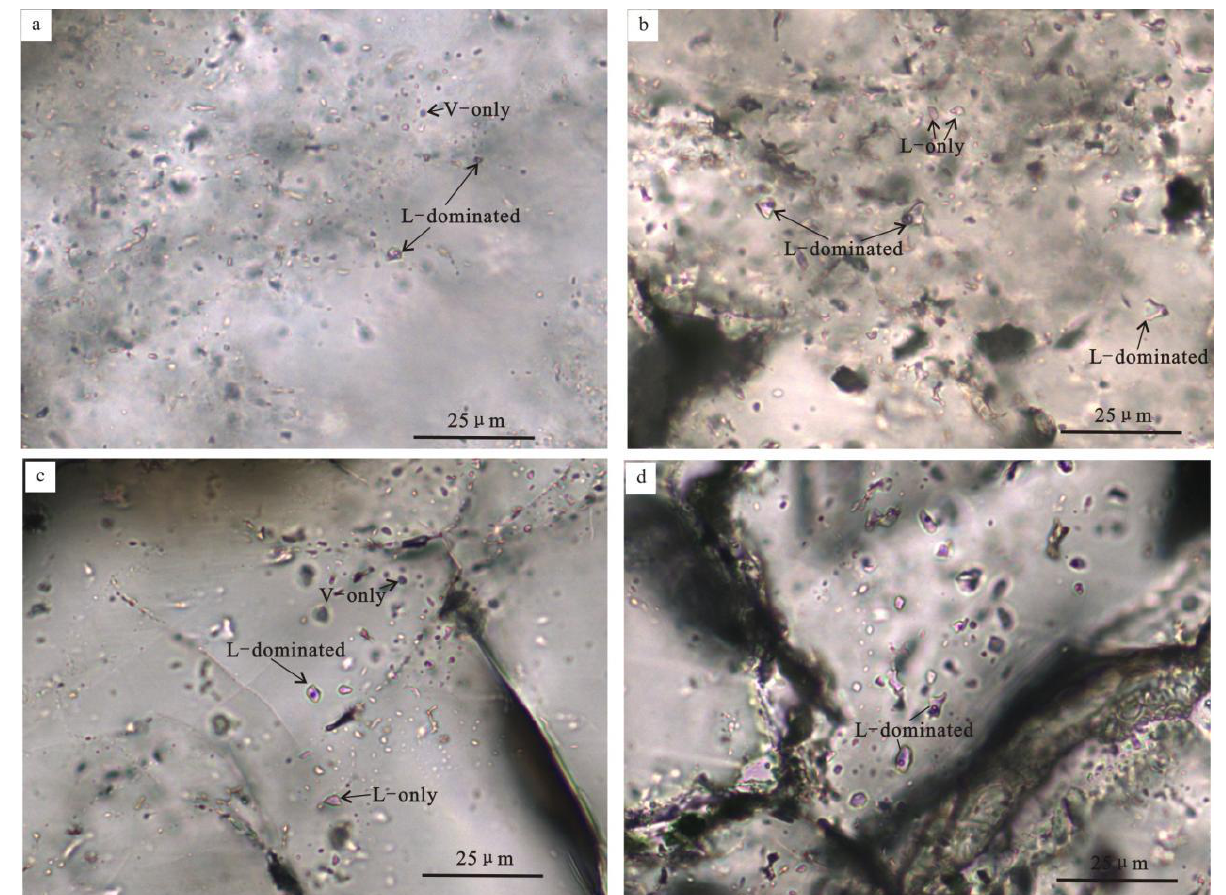
Figure 5. Photomicrographs of the fluid inclusions for the Dongpuzi gold deposit. ( a , b ): V-only, L-only, and L-dominated fluid inclusions within the quartz crystal from ore stage II; ( c , d ): V-only, L-only, and L-dominated fluid inclusions within the quartz crystal from ore stage III)